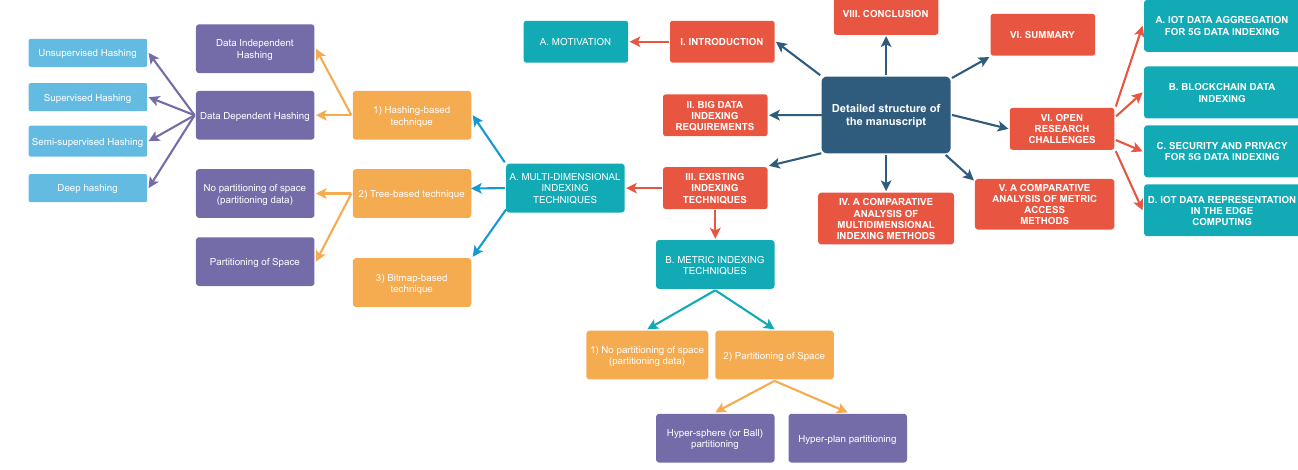
Figure 3. Detailed structure of the